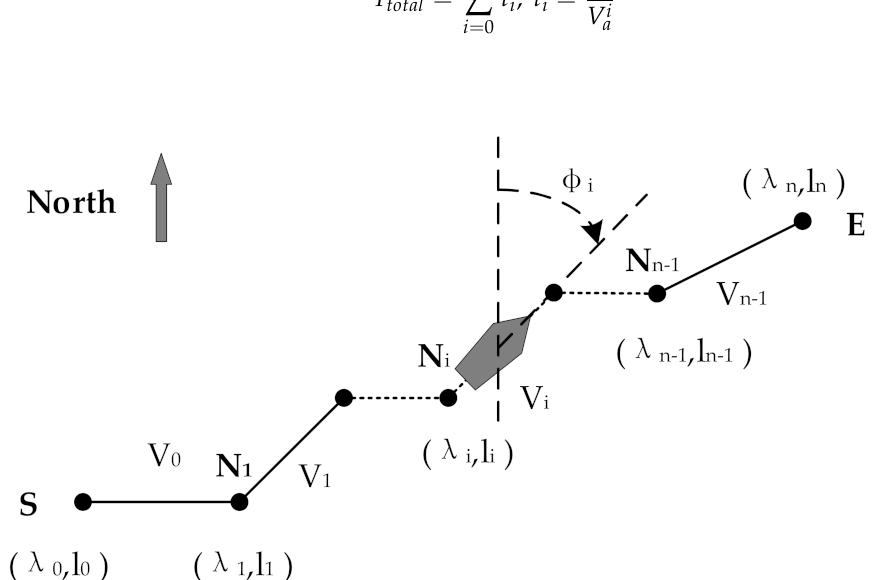
Figure 2. Route diagram comprising multiple